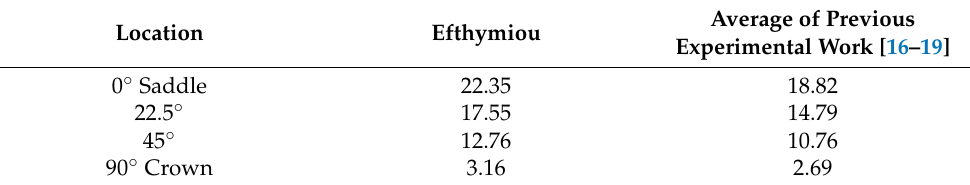
Table 1. SCFs from the chord saddle to crown based on design Efthymiou SCFs and previous experimental work.